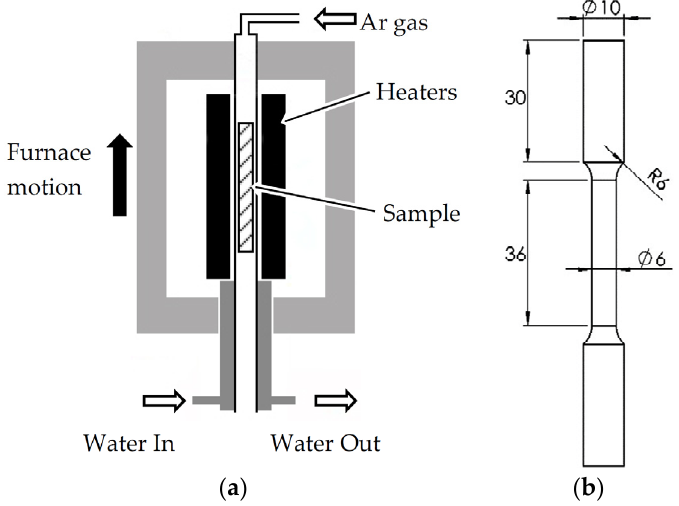
Figure 1. Schematic images of ( a ) the directional solidification equipment and ( b ) a tensile test sample. A T6 heat treatment cycle consisting of, 768 K (495 ◦ C) for 3 h, quenching in 323 K (50 ◦ C) water and 483 K (210 ◦ C) for 2 h, was performed to gain a dissolution and homogenous microstructure in order to study the sole effect of Fe-rich particles without the influence of Cu − and Mg − rich particles. The heat treatment cycle was chosen after studying the work by Sjölander and Seifeddine [25]. These alloys are normally not heat-treated because EN 46000 is commonly high pressure die